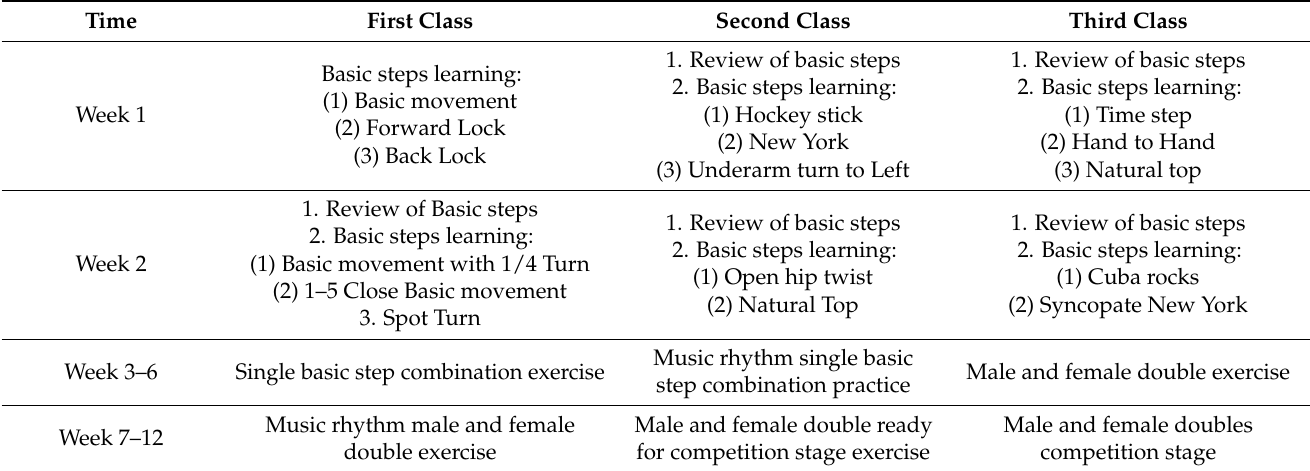
Table 2. Detailed Action Training